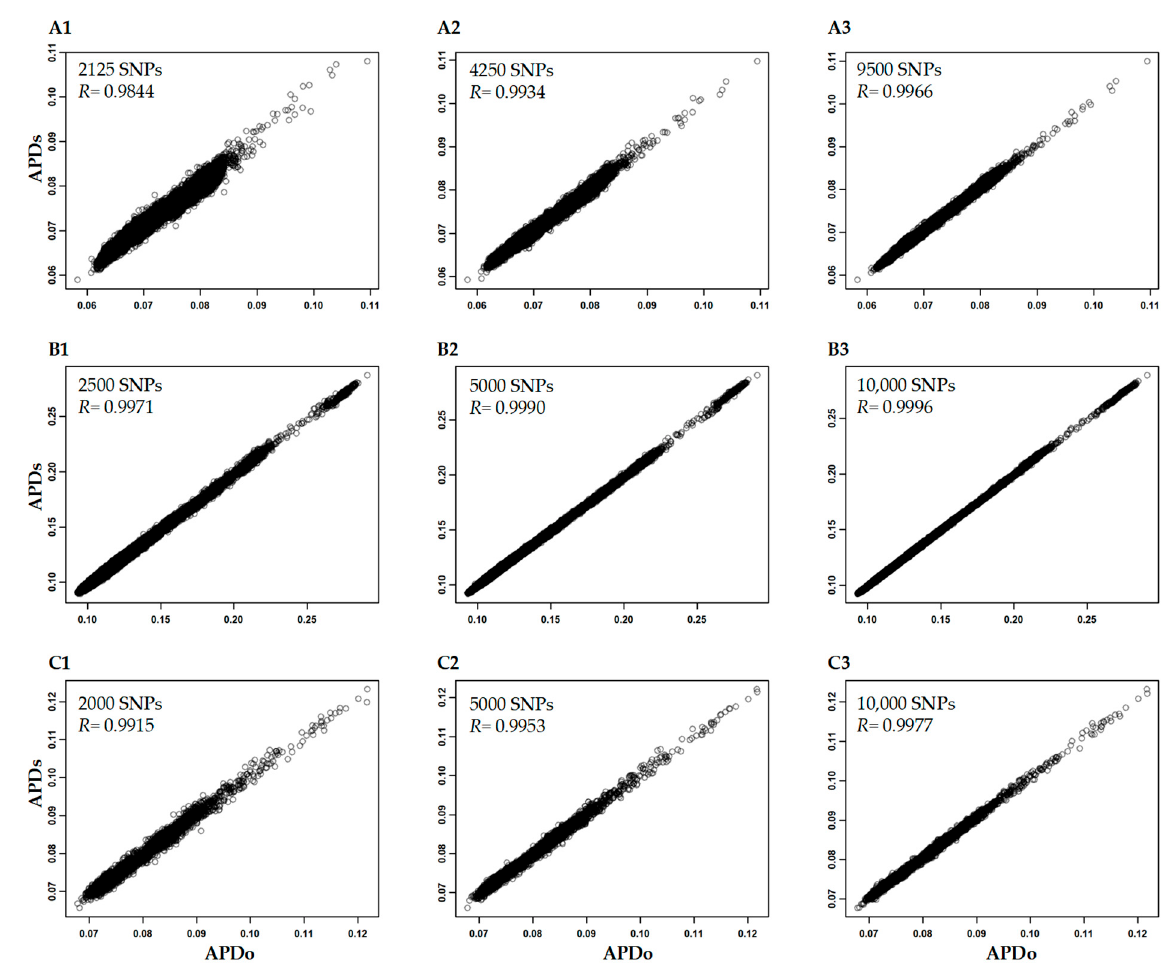
Figure 3. The correlations of APD estimates in the Hordeum vulgare ( A ), Triticum aestivum-f20k ( B ), and Cicer arietinum-f300k ( C ) data sets for all the original SNPs (APDo) and subject to the random selection of 2000 to 10,000 SNPs (APDs).